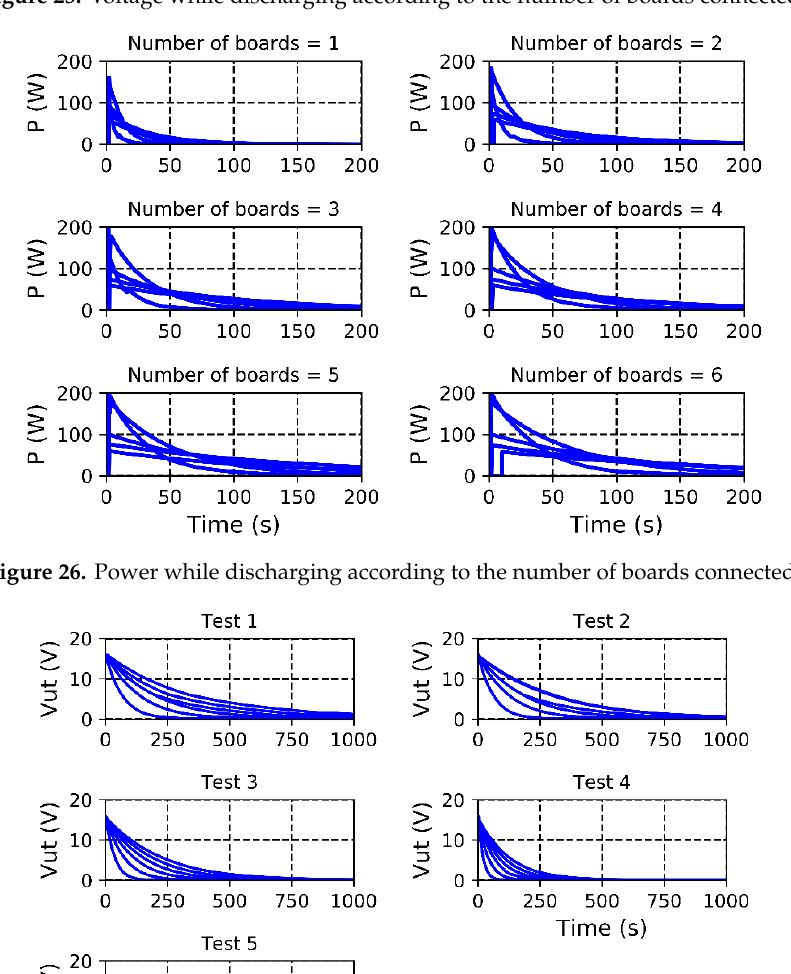
Figure 27. Voltage while discharging according to the number of the test.